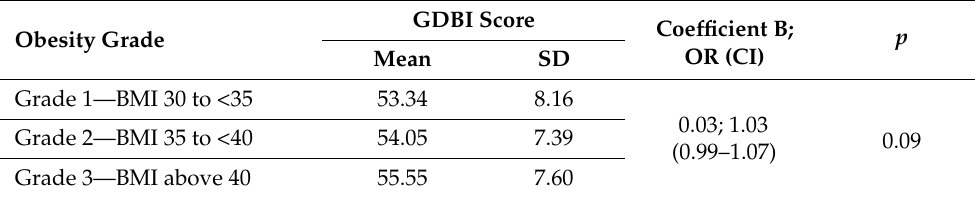
Table 5. Obesity grades and GDBI